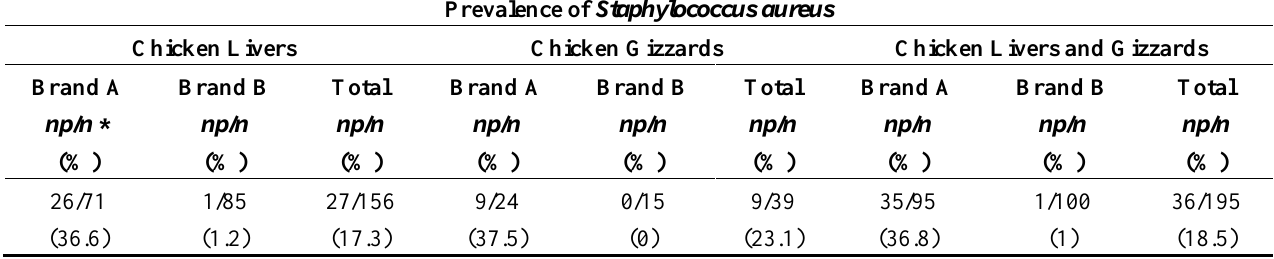
Table 4. Prevalence of Staphylococcus aureus in the 195 collected chicken liver and gizzards